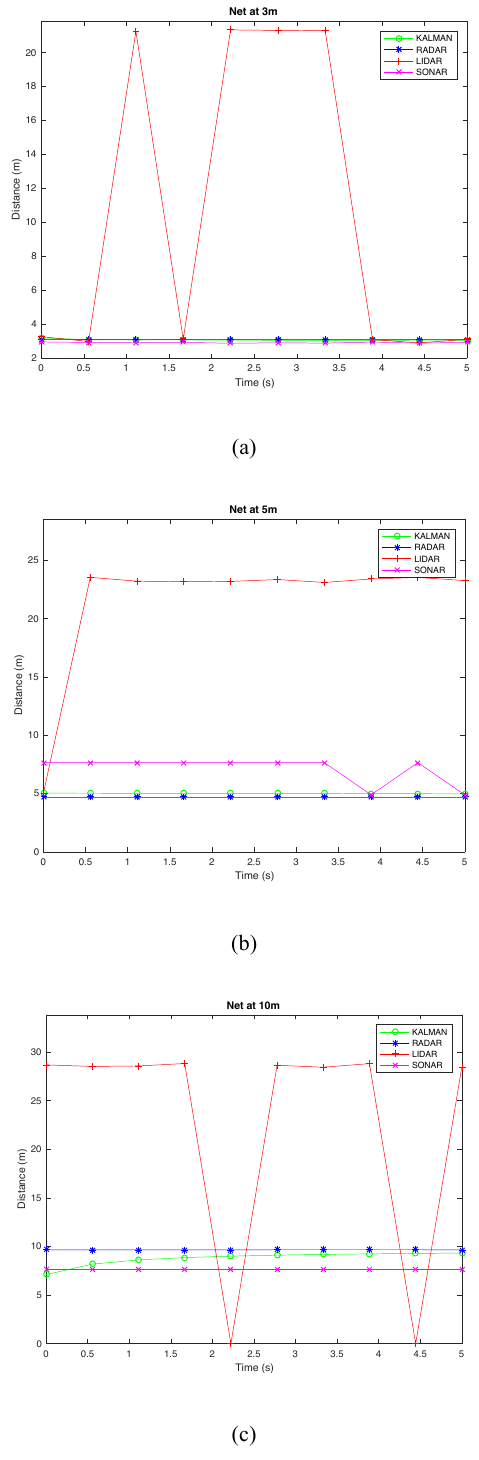
Figure 17 Metal Net at (a) 3m, (b) 5m, (c) 10m distance.